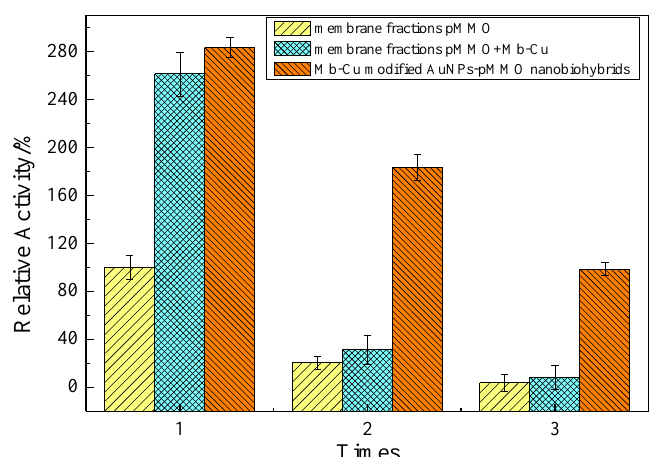
Figure 11. Effect of Mb–Cu on the stability of pMMO in the pMMO-enriched membrane fractions and pMMO–AuNP nanobiohybrids (5 × 10 −3 mol/L dimethyl hydroquinone was added to the reaction’ 100% epoxidation activity = 2.96 nmol∙min −1 ∙mg −1 ).